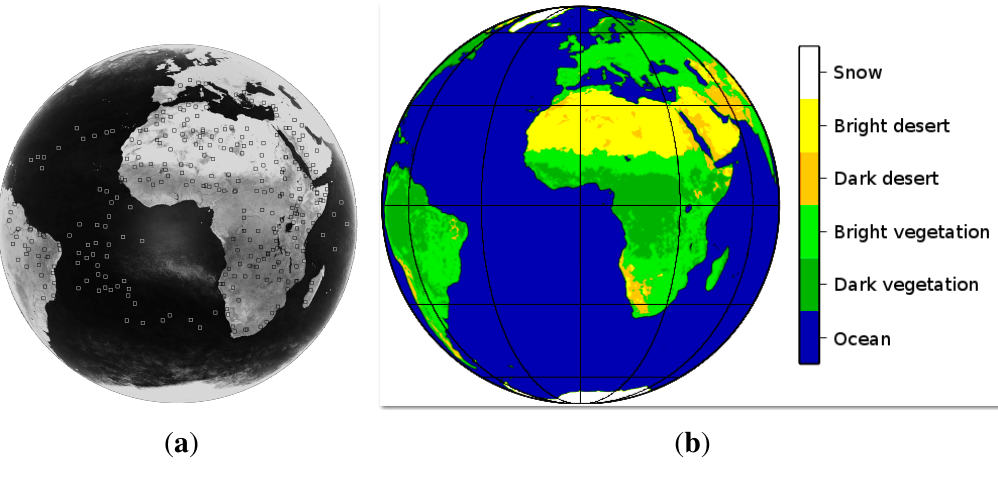
Figure 1. ( a ) Position of the 298 clear-sky targets used in this work; ( b ) The different scene types used to classify the clear-sky